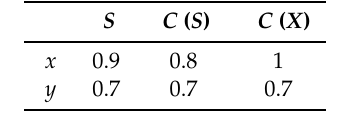
Table 2. The choice function and feasible subsets in Example 2.